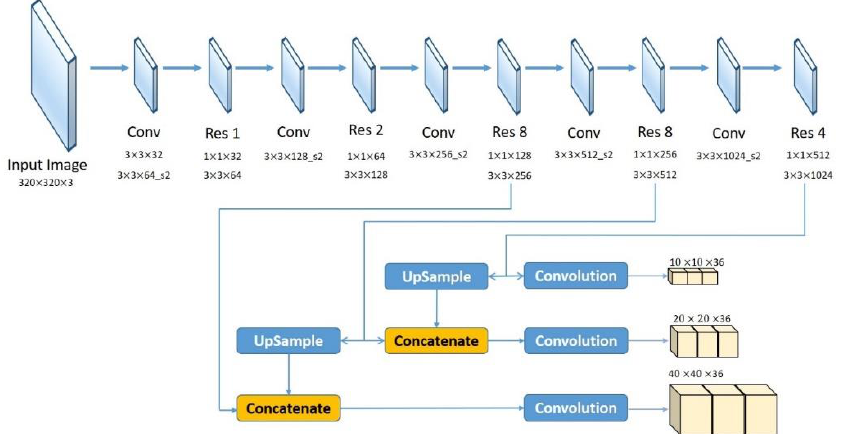
Figure 15. You Only Look Once (YOLOv3) [19] network structure.